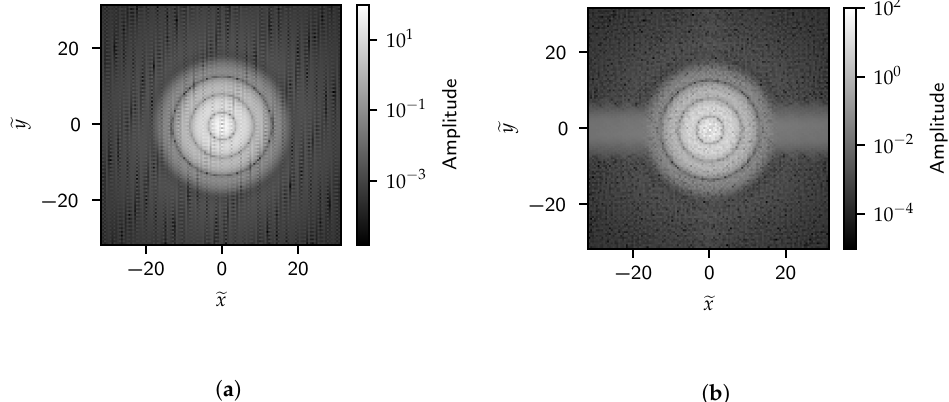
Figure 9. A 2D FFT of the images with ( a ) four and ( b ) nine randomly placed